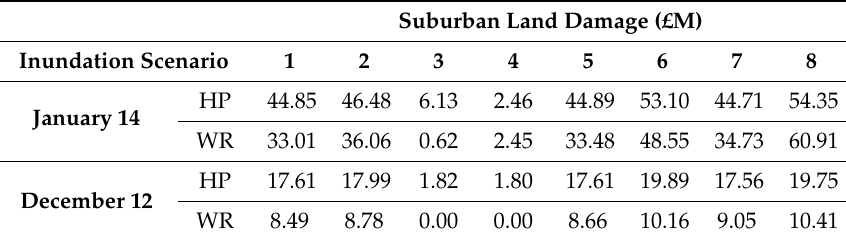
Table 5. Simulated Economic Cost of Inundation for Suburban Land